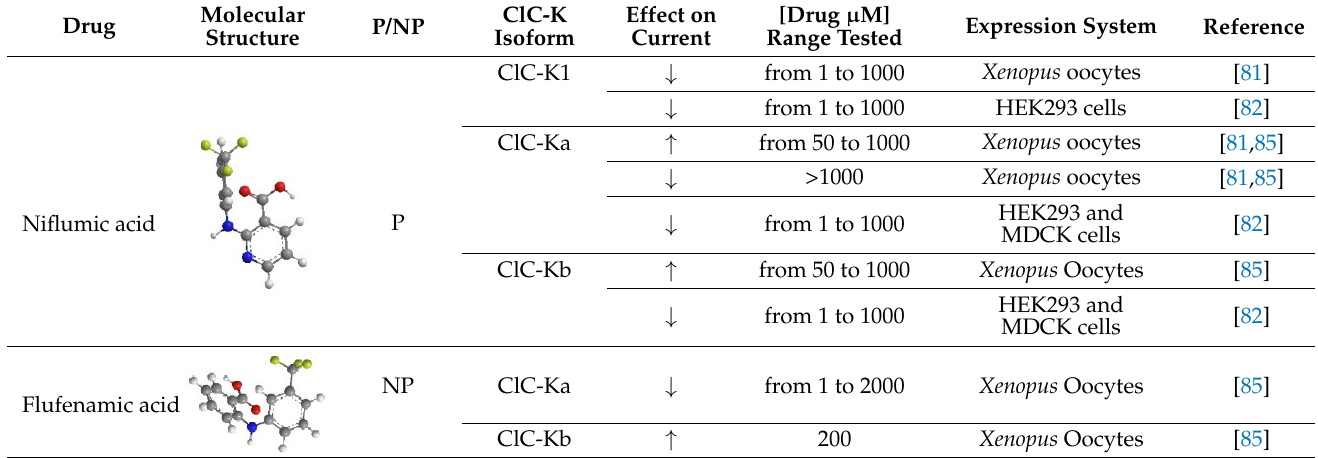
Table 3. Summary of the e ff ects of fenamates on chloride currents sustained by ClC-K channels.